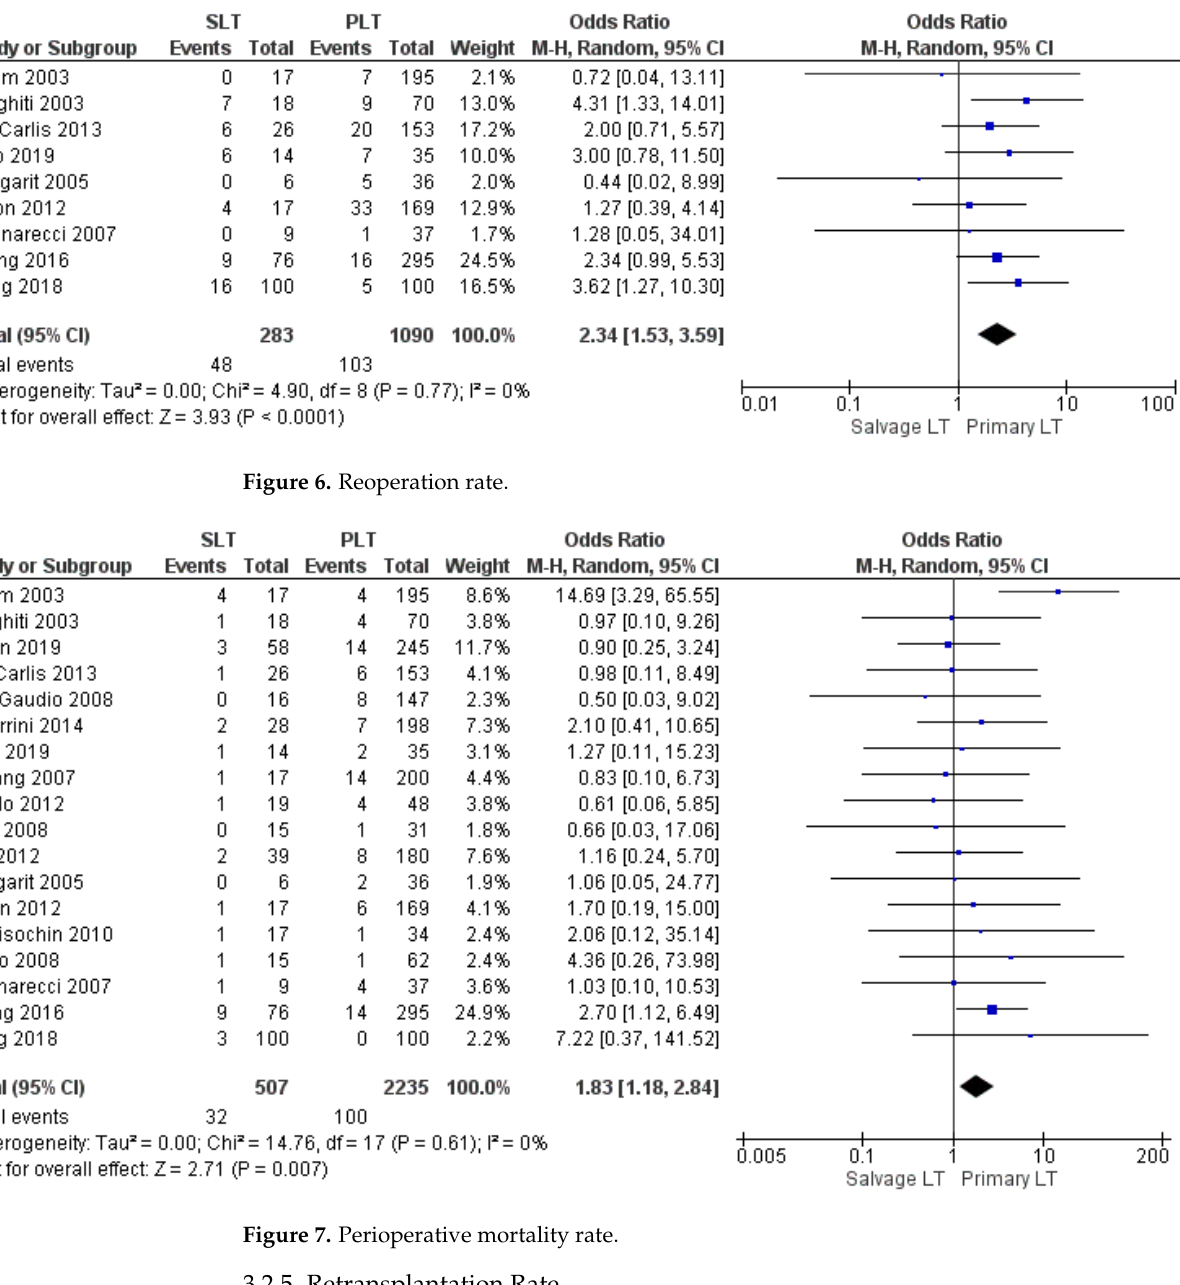
Figure 7. Perioperative mortality rate.